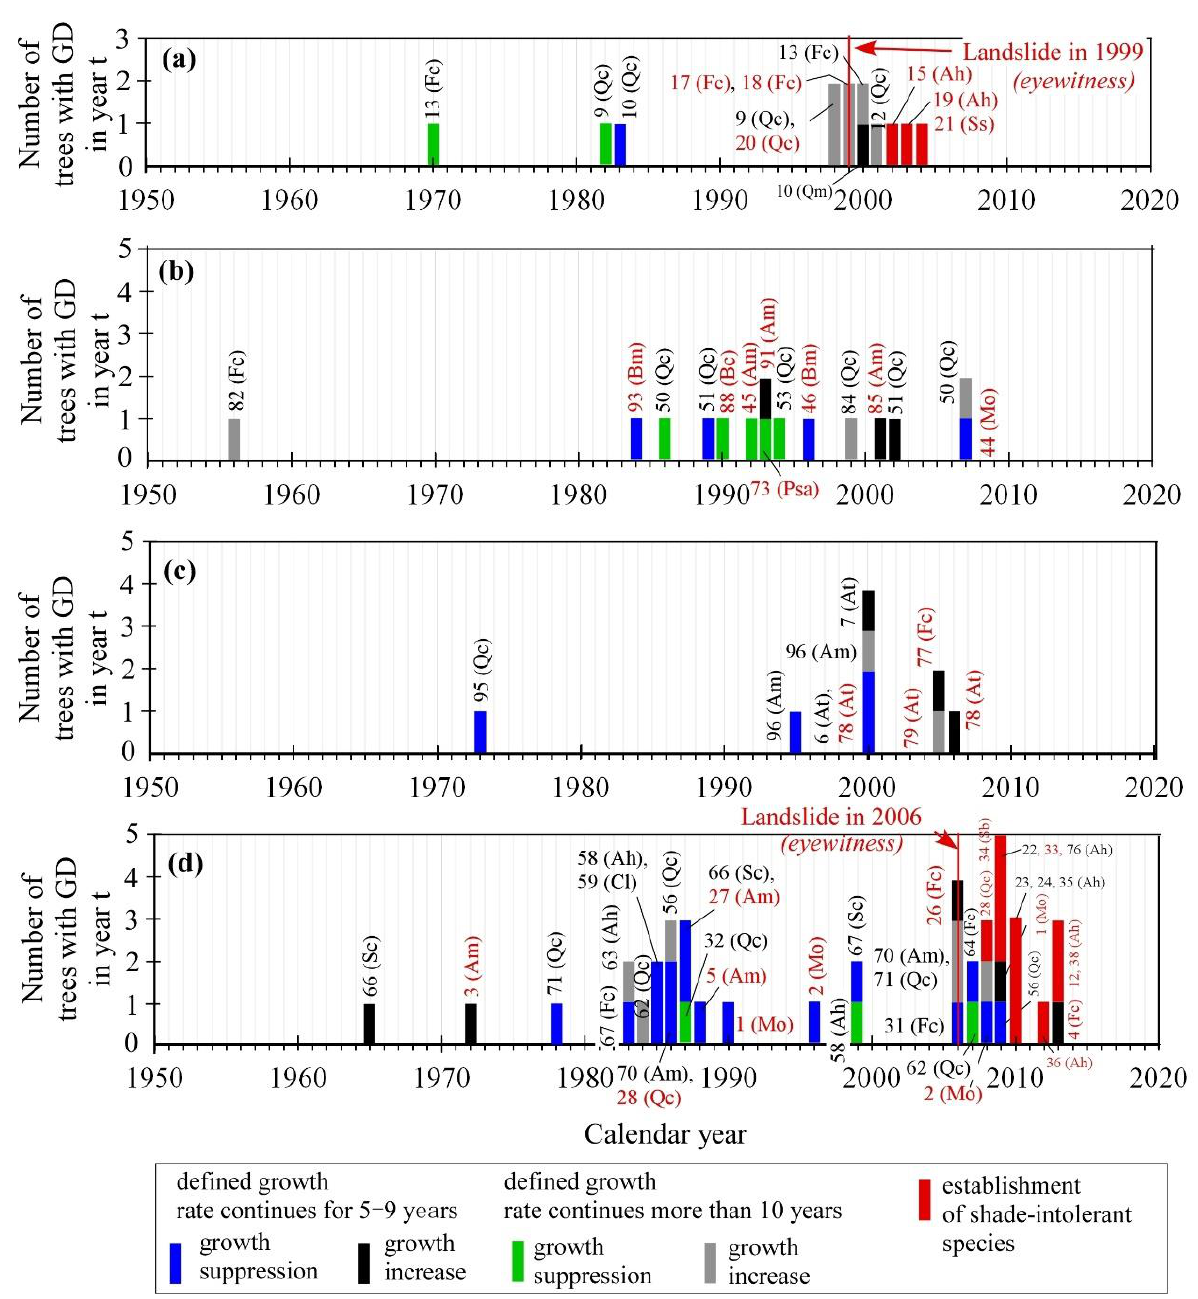
Figure 6. Summary of GD markers identified in the trees and year of establishment of shade-intolerant species for the: ( a ) N-Ohkawa landslide, ( b ) eastern section of the Ohkawa landslide, ( c ) northern section of the Ohkawa landslide, and ( d ) southern section of the Ohkawa landslide. Black and red text indicates samples from the landslide scarp and the displaced landslide block, respectively. Sample locations are shown in Figure 3.